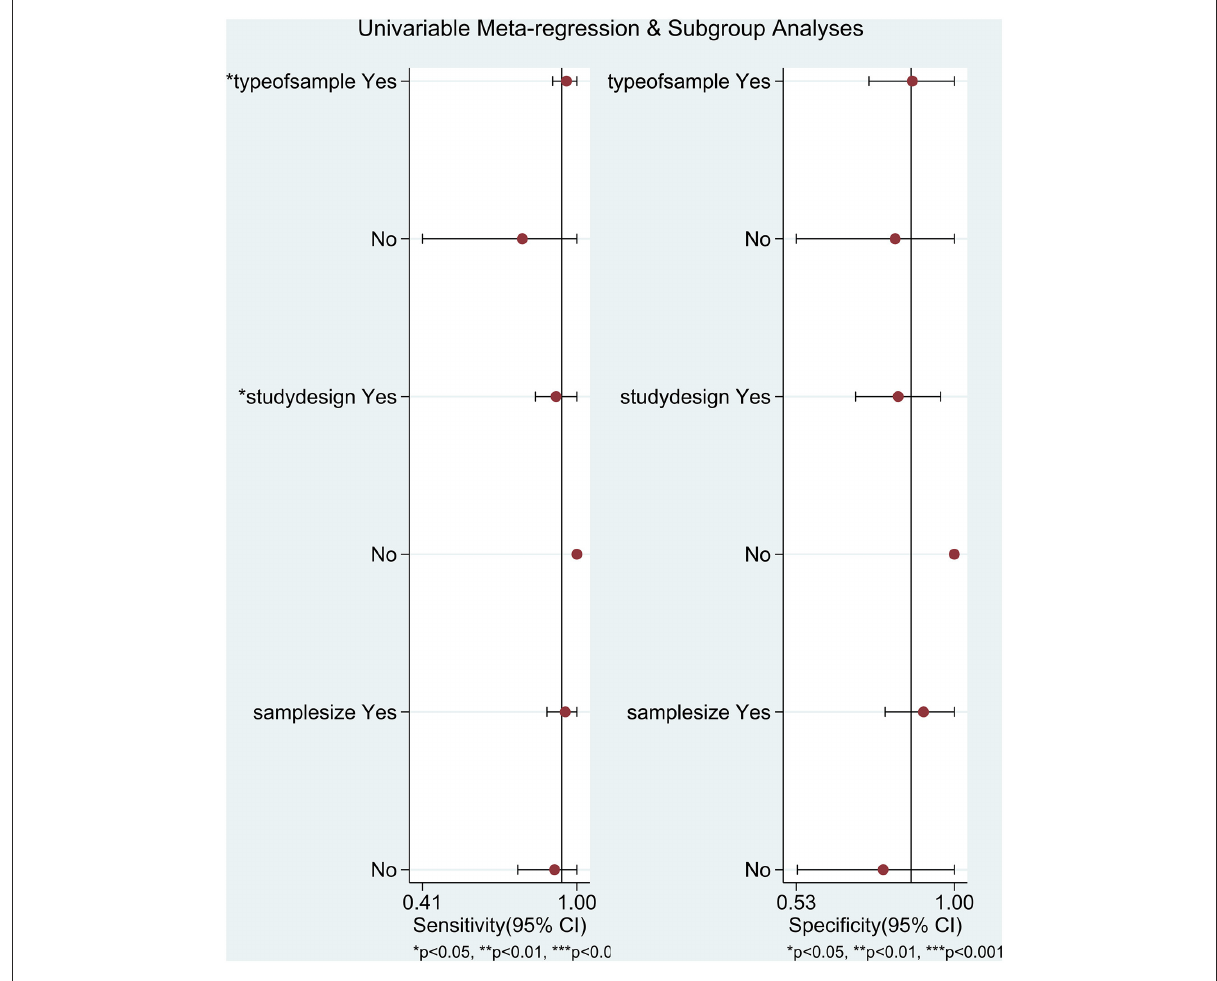
FIGURE6 Univariate meta-regression analysis and subgroup analysis in diagnosing neonatal sepsis. ** P < 0.01, *** P <